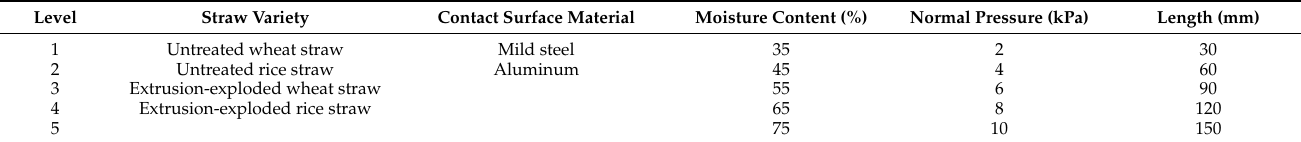
Table 1. The factors and levels of coefficient used in the sliding friction characteristic test.